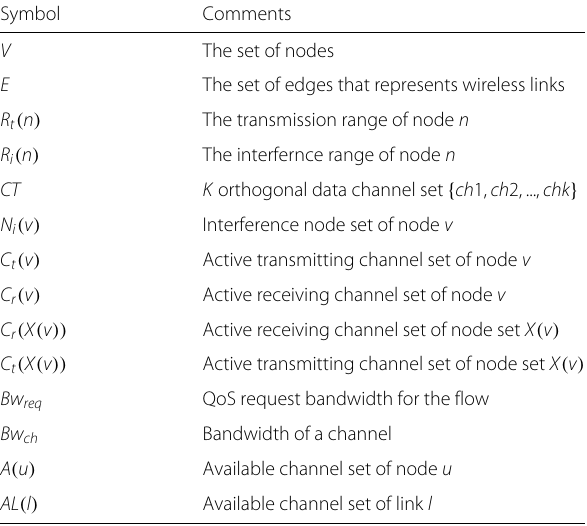
Table 1 Notation used in the